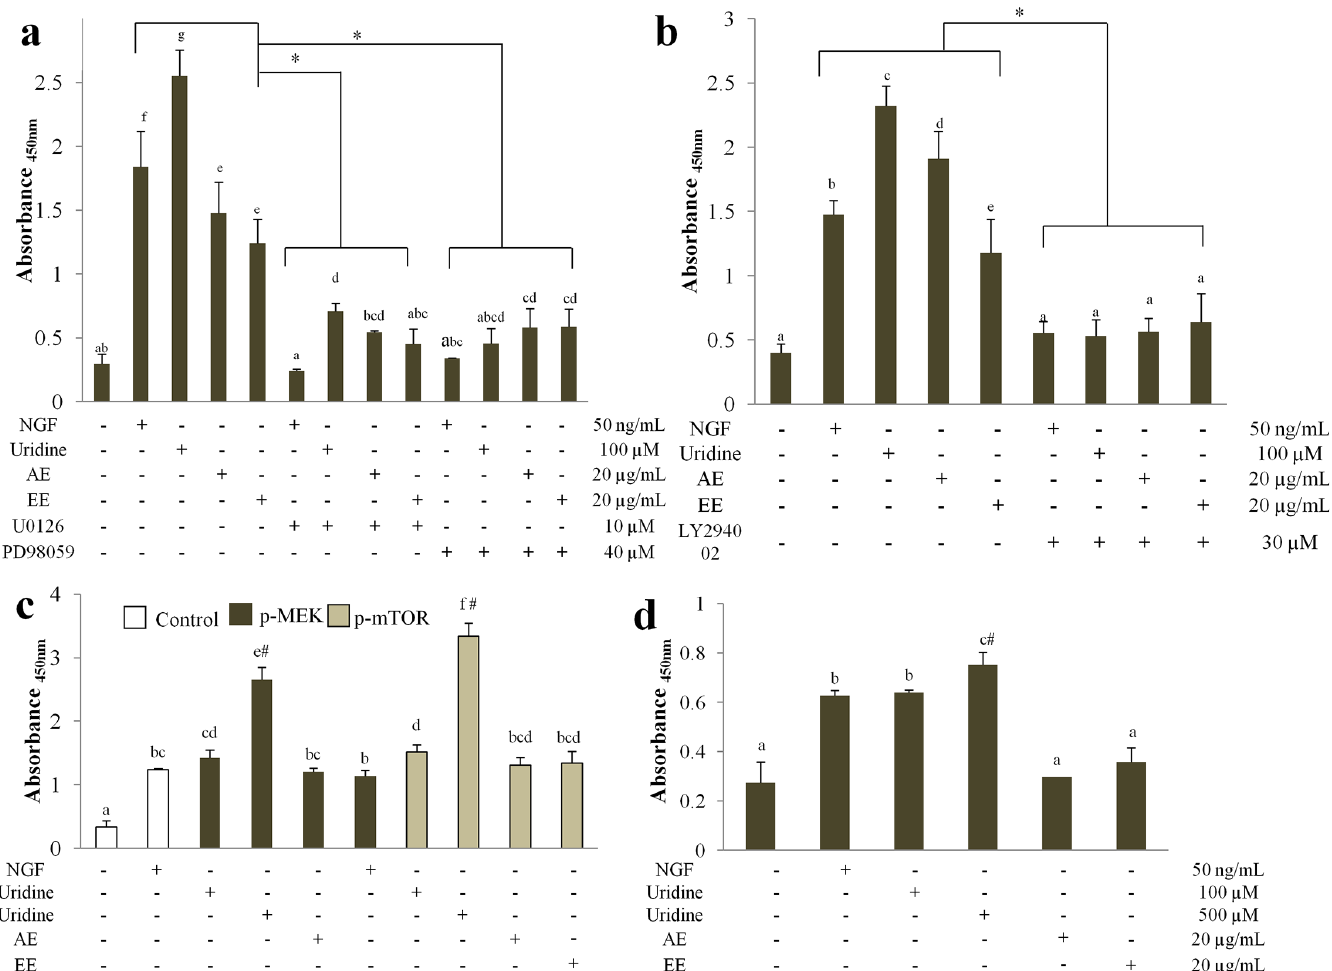
Fig 6. Enhancement of uridine-induced neurite outgrowth is (a) ERK-, (b) Akt-, (c) MEK- & mTOR-, and (d) CREB-dependent as evidenced by the expression of phospho-ERK1/2 (p44/p42), Akt (Thr308), MEK (Ser217/221) & mTOR (Ser2448), and CREB (Ser133) as detected using specific antibodies. U0126 and PD98059 are the inhibitors for ERK. LY294002 is the inhibitor for PI3K/Akt. Data are expressed as mean ± S.D. for n = 3. Different alphabets represent significant differences between samples ( p < 0.05). * p < 0.05 significantly lower relative to group without inhibitor treatment. # p < 0.05 significantly higher relative to